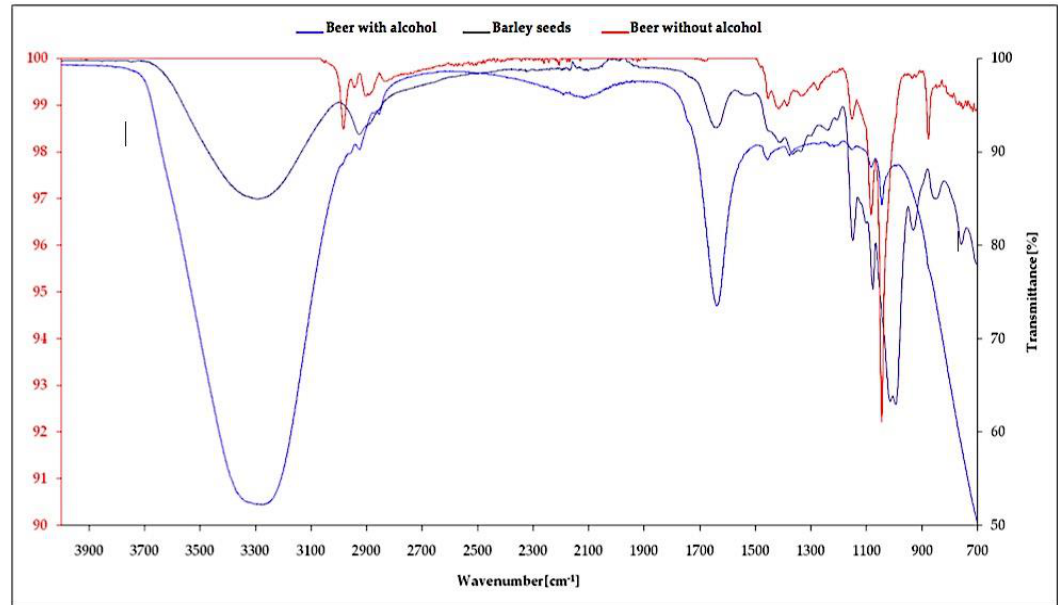
Figure 5. FTIR (Fourier transform infrared spectroscopy) spectra of alcoholic, non-alcoholic beer, and barley seeds.